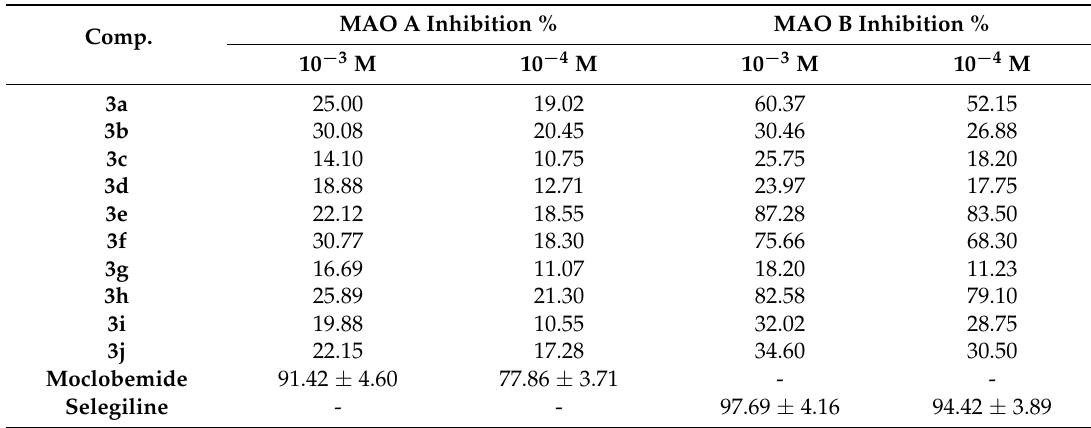
Table 1. Percent inhibition of compounds 3a – 3j , moclobemide and selegiline against MAO-A and MAO-B at 10 − 3 M to 10 − 4 M concentrations. Comp.